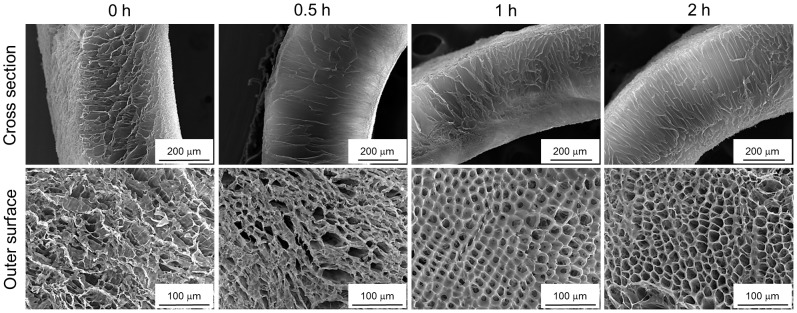
Influence of the coarsening time.SEM images of the cross section and the outer surface of the PLCL300 (3% w/v) foams prepared by quenching at −25°C for 30 s and coarsening for various times (0, 0.5, 1 and 2 h) suggested that an increase in the coarsening time resulted in better organization of the solvent rich phase what after solvent removal led to well-ordered pores.